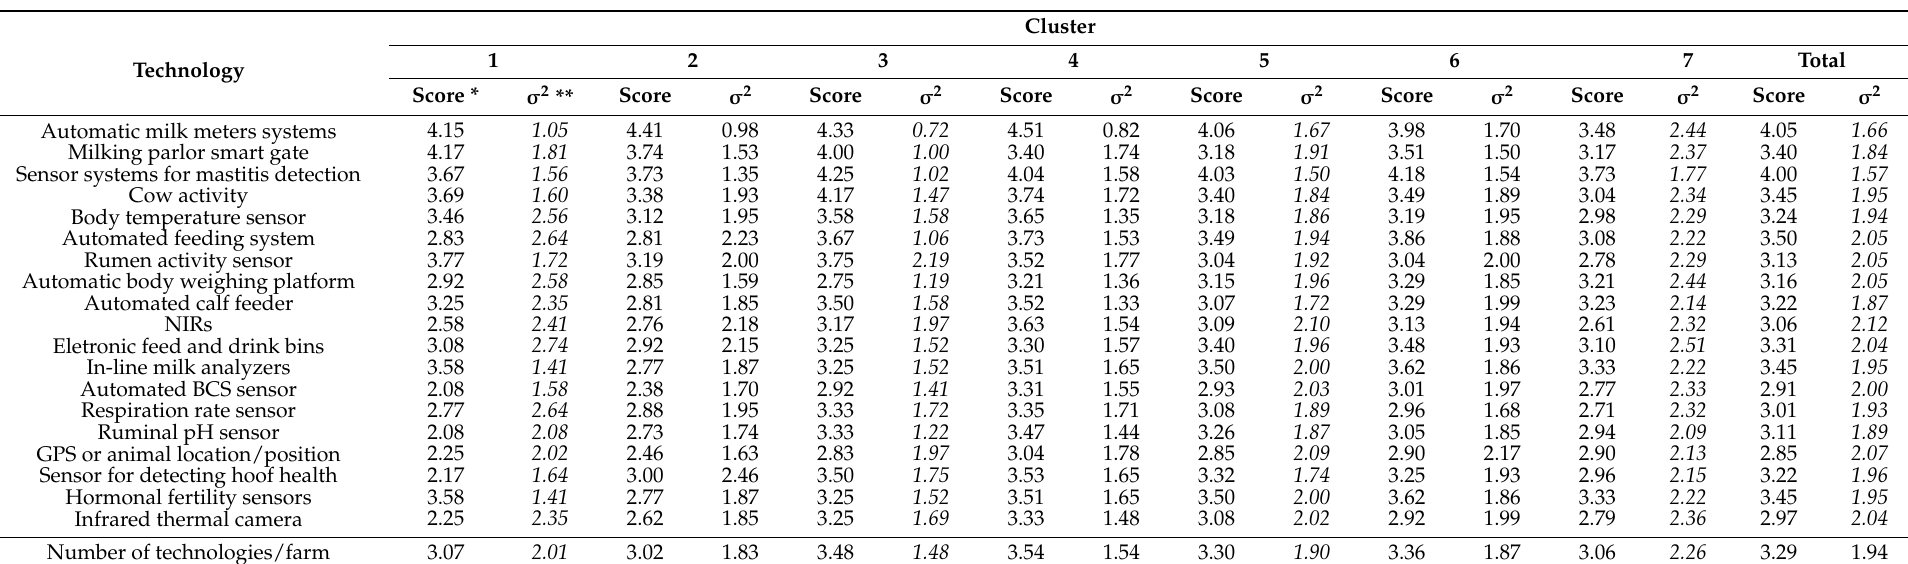
Table 9. Farmers’ perception about the usefulness of different precision technologies.